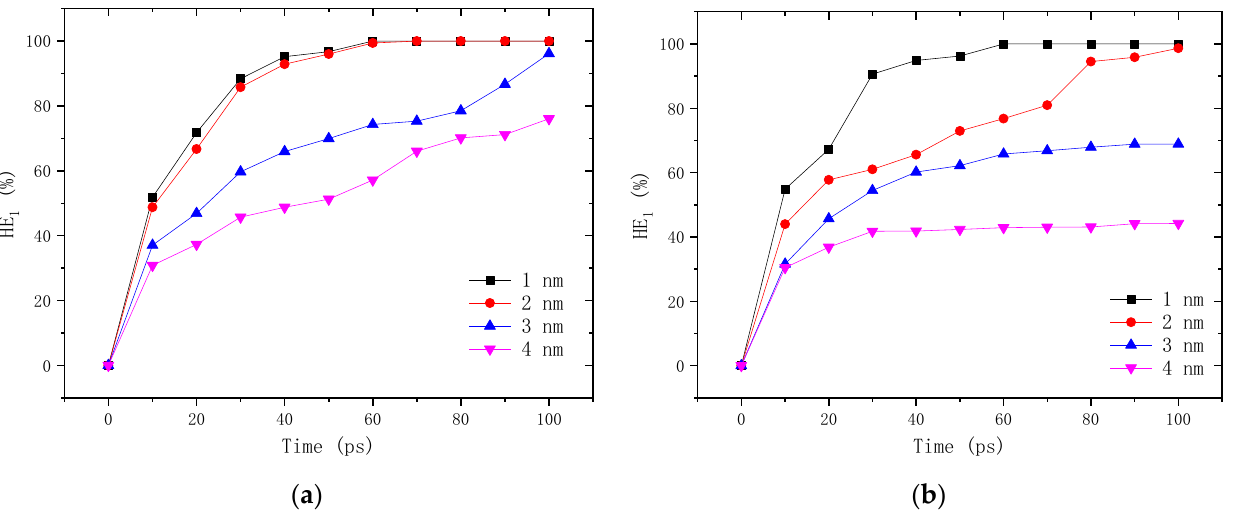
Figure 11. Self-healing efficiency of asphalt binder with different damage degrees at 298.15 K: ( a ) neat asphalt binder; ( b ) aged asphalt binder.